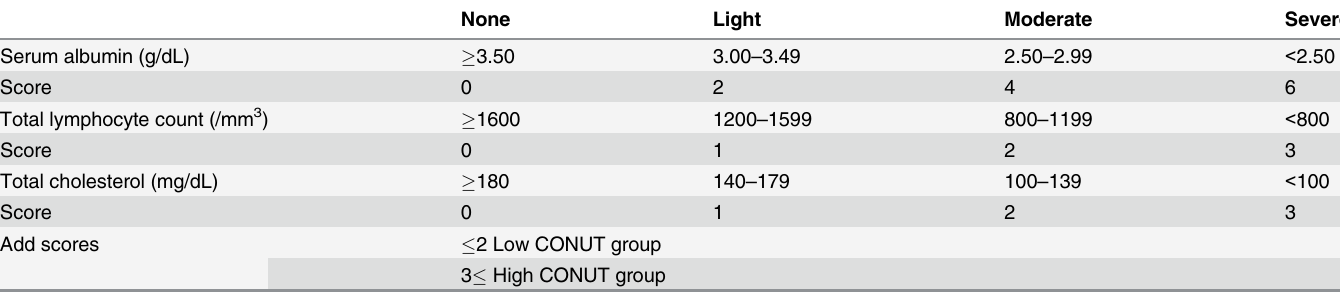
Table 1. Assessment of the nutritional status using the CONUT